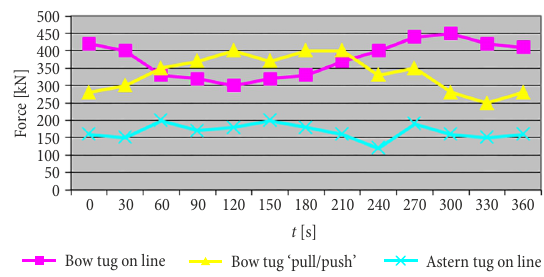
Fig. 17. Tug bollard pull during the ship mooring operation